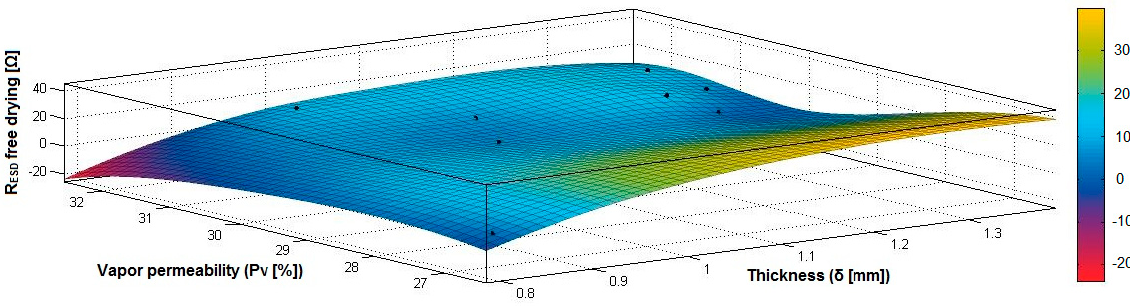
Figure 23. 3D representation R ESD free drying = f(Pa, Pv) for samples preliminarily treated in RF plasma O 2 using RF 1 generator and power 200 W.